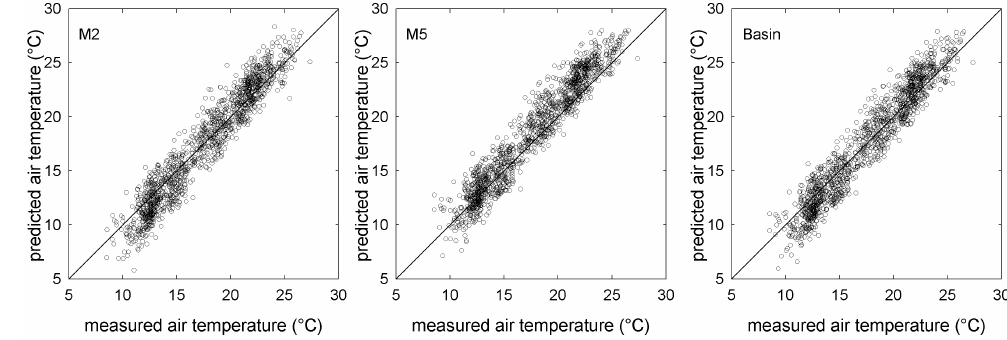
Fig. 6. Scatter plots of model vs. buoy’s air temperature hourly data for the M2, M5 grid points and the “average basin”.